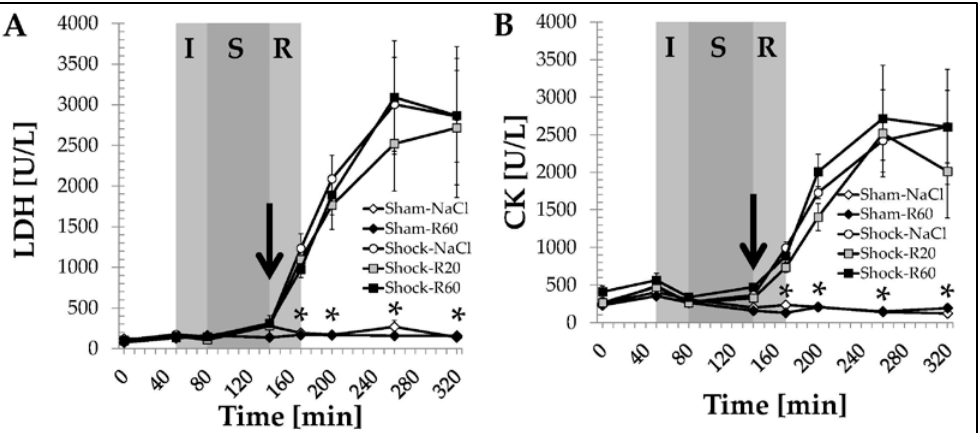
Figure 5. Effect of continuous intravenous infusions of solvent-free low-dose resveratrol on plasma lactate dehydrogenase (LDH) and creatine kinase (CK) activities subsequent to severe hemorrhagic shock in rats. Rats underwent severe hemorrhage (30 min shock induction, I; 60 min shock phase, S), then were resuscitated (R, within 30 min) with the withdrawn blood and LR equal to twice the volume of the withdrawn blood (30 min) in the absence (Shock-NaCl) or presence of resveratrol (20 or 60 μg/kg × h until the end of the experiment; Shock-R20, Shock-R60) and observed for a further 150 min. Sham animals received either pure 0.9% NaCl solution (Sham-NaCl) or the higher resveratrol dose (Sham-R60). Lactate dehydrogenase (LDH, A ) and creatine kinase (CK, B ) activities were determined in plasma from arterial blood samples as obtained at the time points indicated. Shown are mean values ± SEM ( n = 8 animals per group). * p < 0.05 (vs. Shock-NaCl). The arrow indicates the start of the resveratrol infusions.